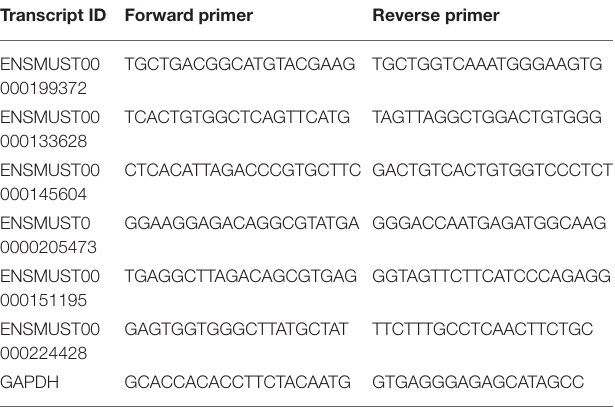
TABLE 2 | Primers used in